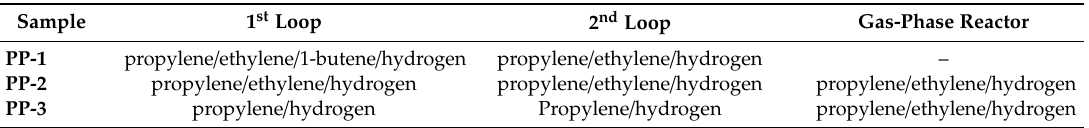
Table 1. Polymerization comonomers used in the reactors of the Spheripol process for the preparation of PP-1/PP-2/PP-3.